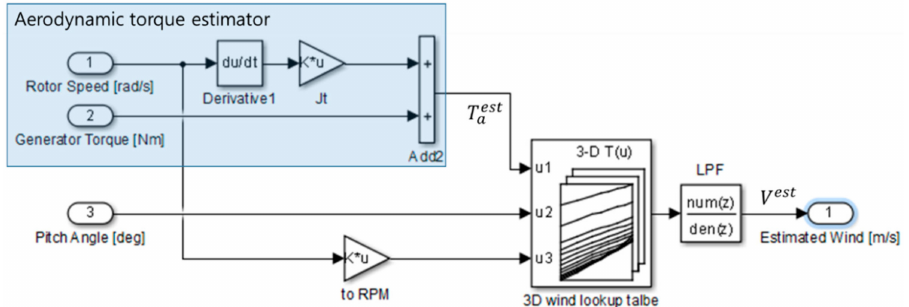
Figure 9. Block diagram of the wind speed estimator. Low pass filter (LPF); Revolutions per minute